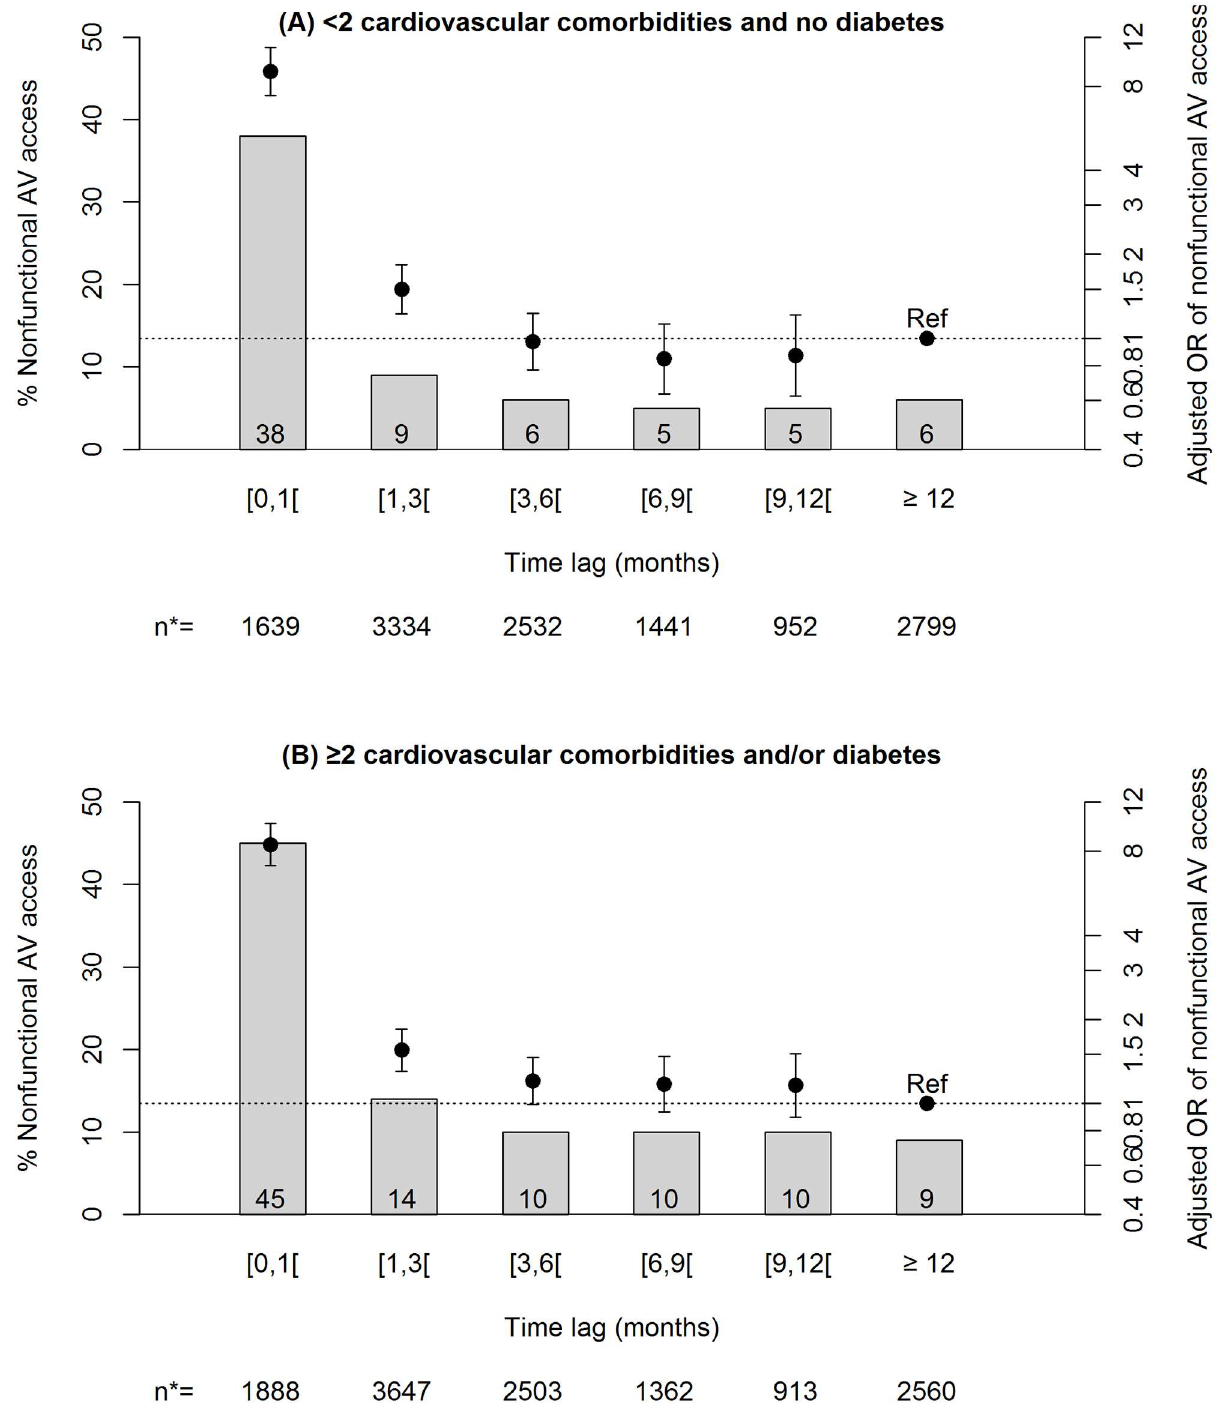
Fig 2. Prevalence and adjusted odds ratios of nonfunctional AV accessat hemodialysis initiation according to timing of AV accesscreation and comorbidities in patients with a planned dialysis start. N * = number of patients within time lags through the 20 imputed data sets. Analyseswere adjustedfor all variablesin Table 1 plus year of hemodialysis initiationand the region’sannualpercentage of patients with predialysis AV access. P -valueof interactionbetweencomorbidity profile and timing of AV access creation: 0.059. P -valueof timing of AV access creation in both stratified models: < 0.001. Abbreviations: AV, arteriovenous; ref, reference.